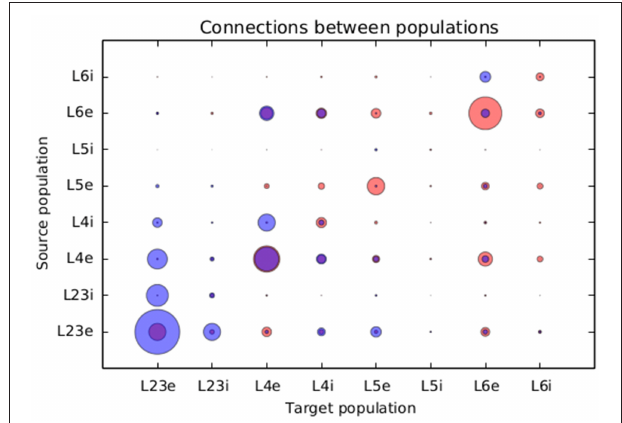
FIGURE 8 | Comparison of the normalized connectivity in the microcircuit model between the results obtained with the structural plasticity framework (red) and the values reported by Potjans and Diesmann (2014) (blue). The radius of the circle represents the linearly normalized value of the percentage of connections between